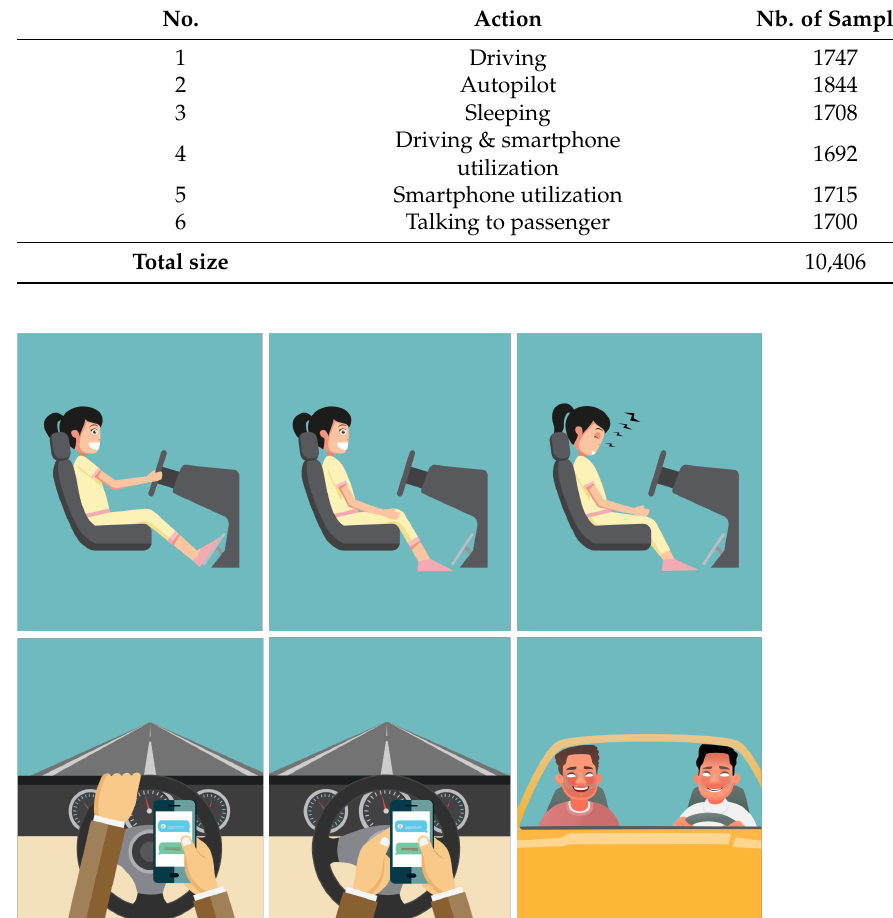
Table 2. Overview of the data extracted from RaDA . Each file contains a one-second window from a particular driving action.